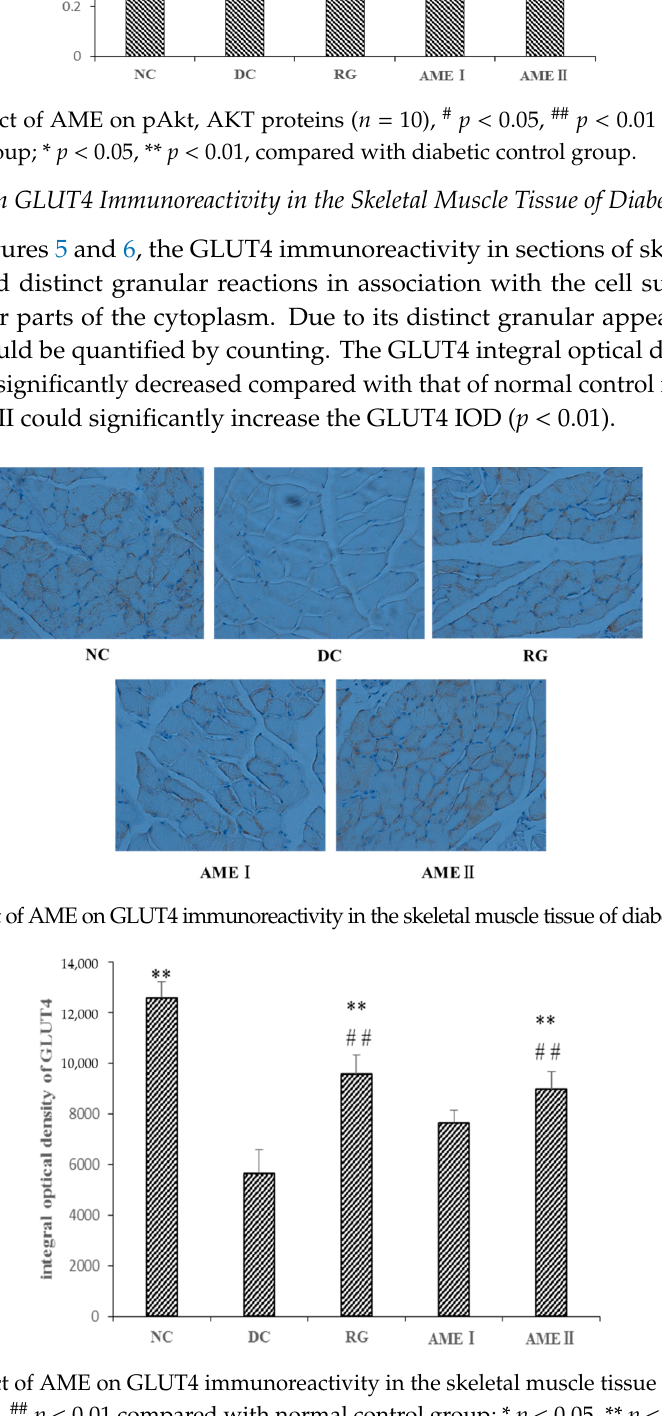
Figure 4. The effect of AME on pAkt, AKT proteins ( n = 10), # p < 0.05, ## p < 0.01 compared with normal control group; * p < 0.05, ** p < 0.01, compared with diabetic control group.